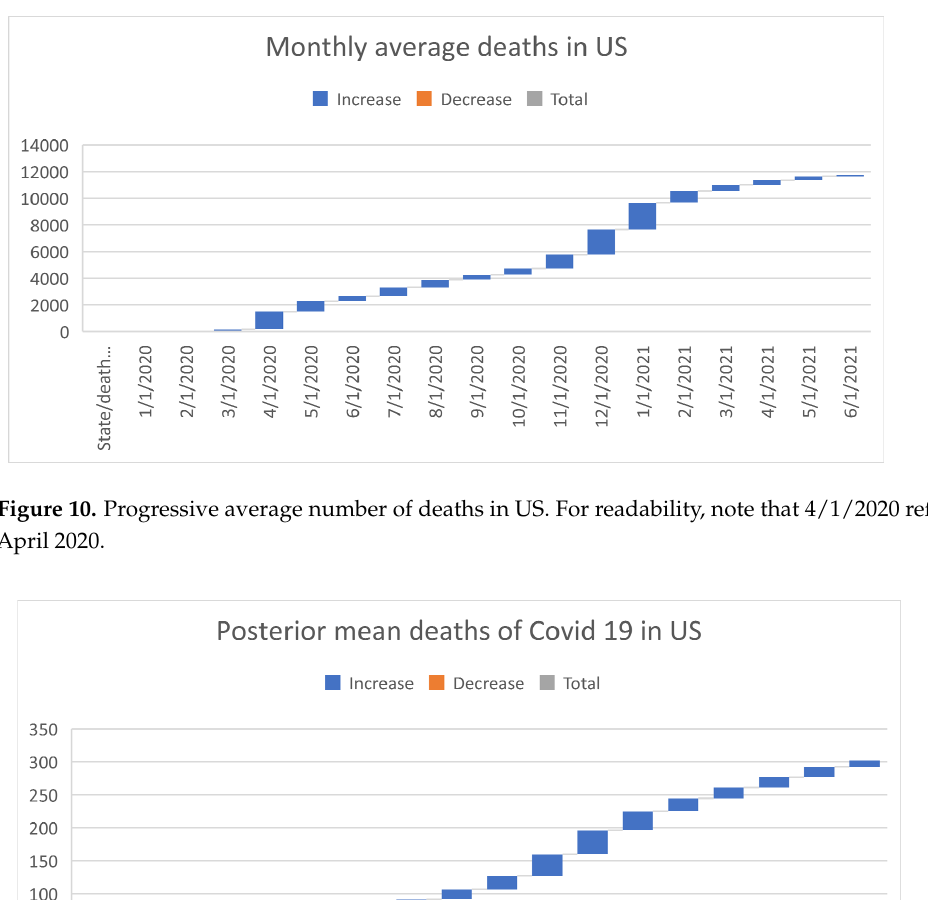
Figure 9. Progressive balancing factor in US. For readability, note that 4/1/2020 refers 1April 2020. Healthcare 2021 , 9 , x FOR PEER REVIEW